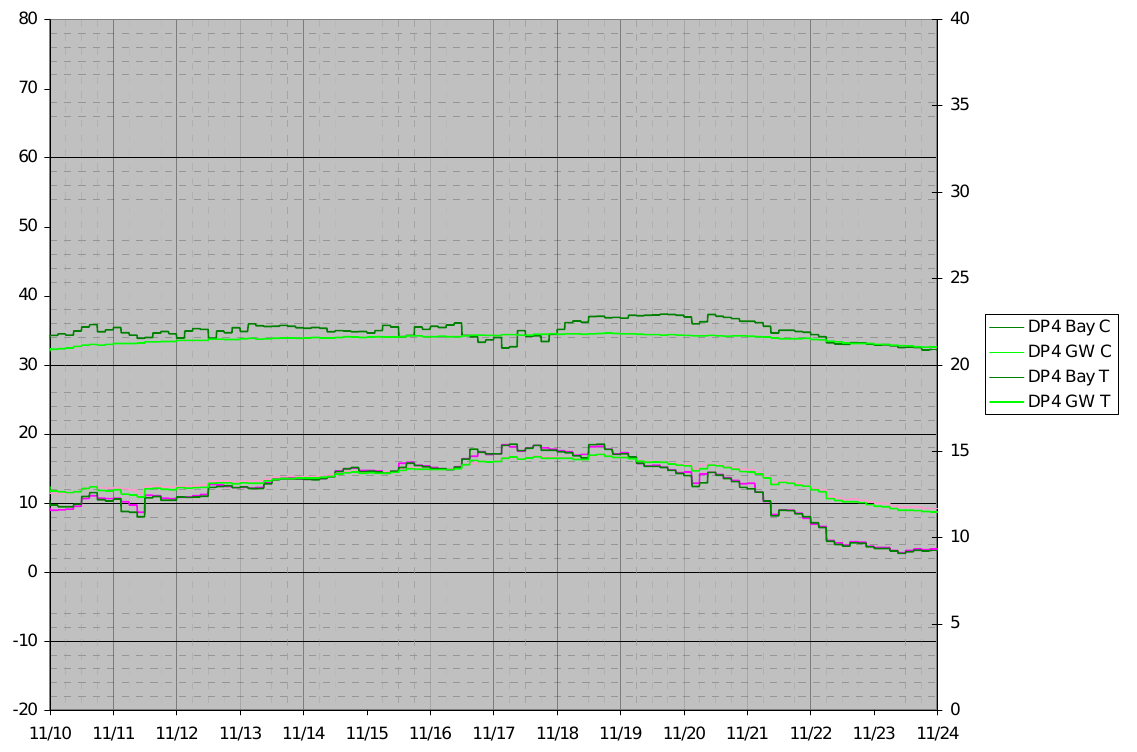
Figure 10. Conductivity and temperature data from one of the DP loggers deployed in Waquoit Bay, MA, in November 2006.